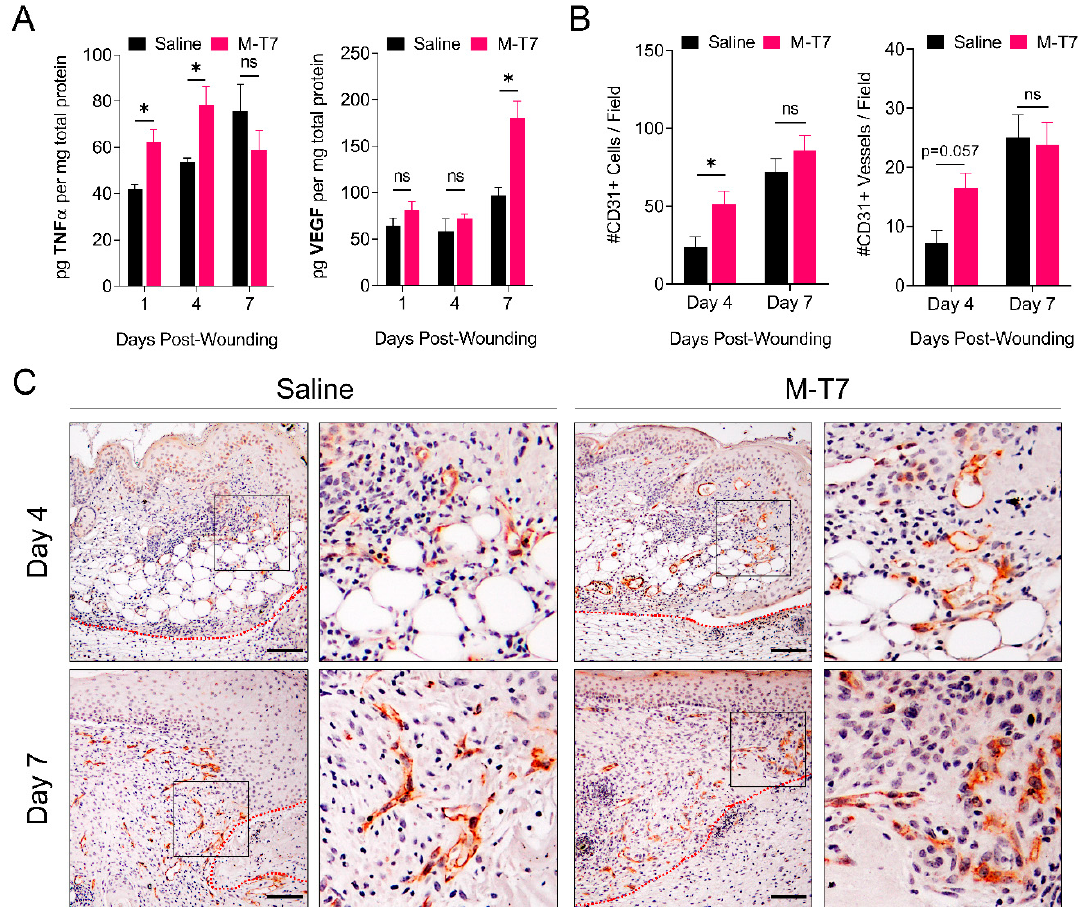
Figure 3. Assessment of peri-wound angiogenesis in wounds treated with M-T7. ( A ) ELISA quantification of TNF α and VEGF in wound tissues treated with saline or M-T7 collected on days 1, 4 and 7 post-wounding normalized to total protein. Bars are mean and standard error. Statistics were calculated by two-way ANOVA with Fisher’s LSD post-hoc analysis. ( B ) Quantification of CD31 + cells and vessels per 20 × field in the peri-wound area of wounds treated with saline or M-T7 collected on days 4 and 7 post-wounding. Bars are mean and standard error. Two non-overlapping fields were quantified per mouse and statistics were performed on the average per mouse with the N = 4 per group. Statistics were calculated by two-way ANOVA with Fisher’s LSD post-hoc analysis. ( C ) Representative peri-wound CD31 IHC fields (10 × ) collected on days 4 and 7 post-wounding. Scale bars are 50 µ m. Zoom areas indicated by boxes. N = 3–4 in each group and time point.